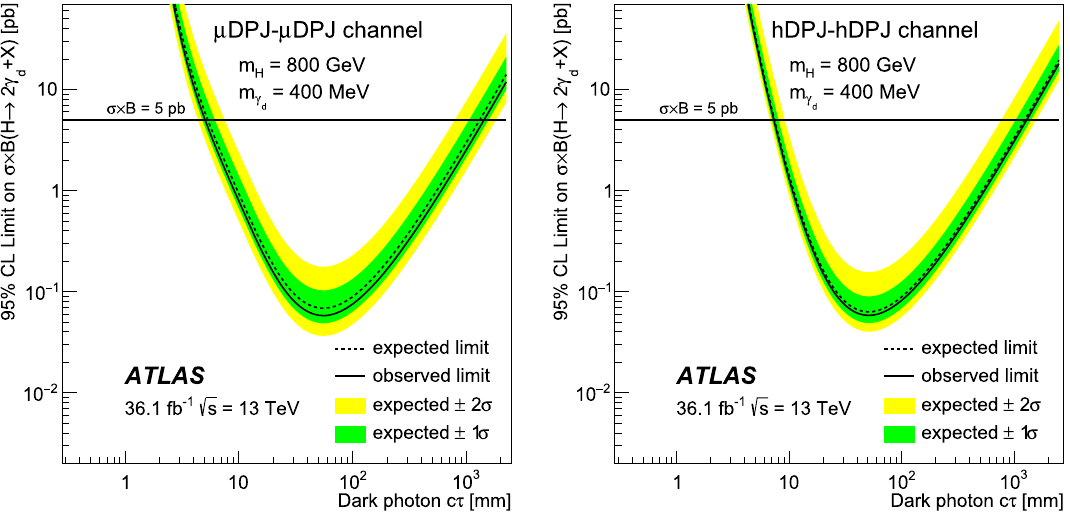
Fig. 6 Upper limits at 95% CL on the cross section times branching fraction for the process H → 2 γ d + X , where H is an 800 GeV BSM Higgs boson, in the μ DPJ– μ DPJ (left) and hDPJ–hDPJ (right) final states. The horizontal lines correspond to a cross section times branching fraction of 5 pb Table 6 Ranges of γ d c τ excluded at 95% CL for H → 2 γ d + X